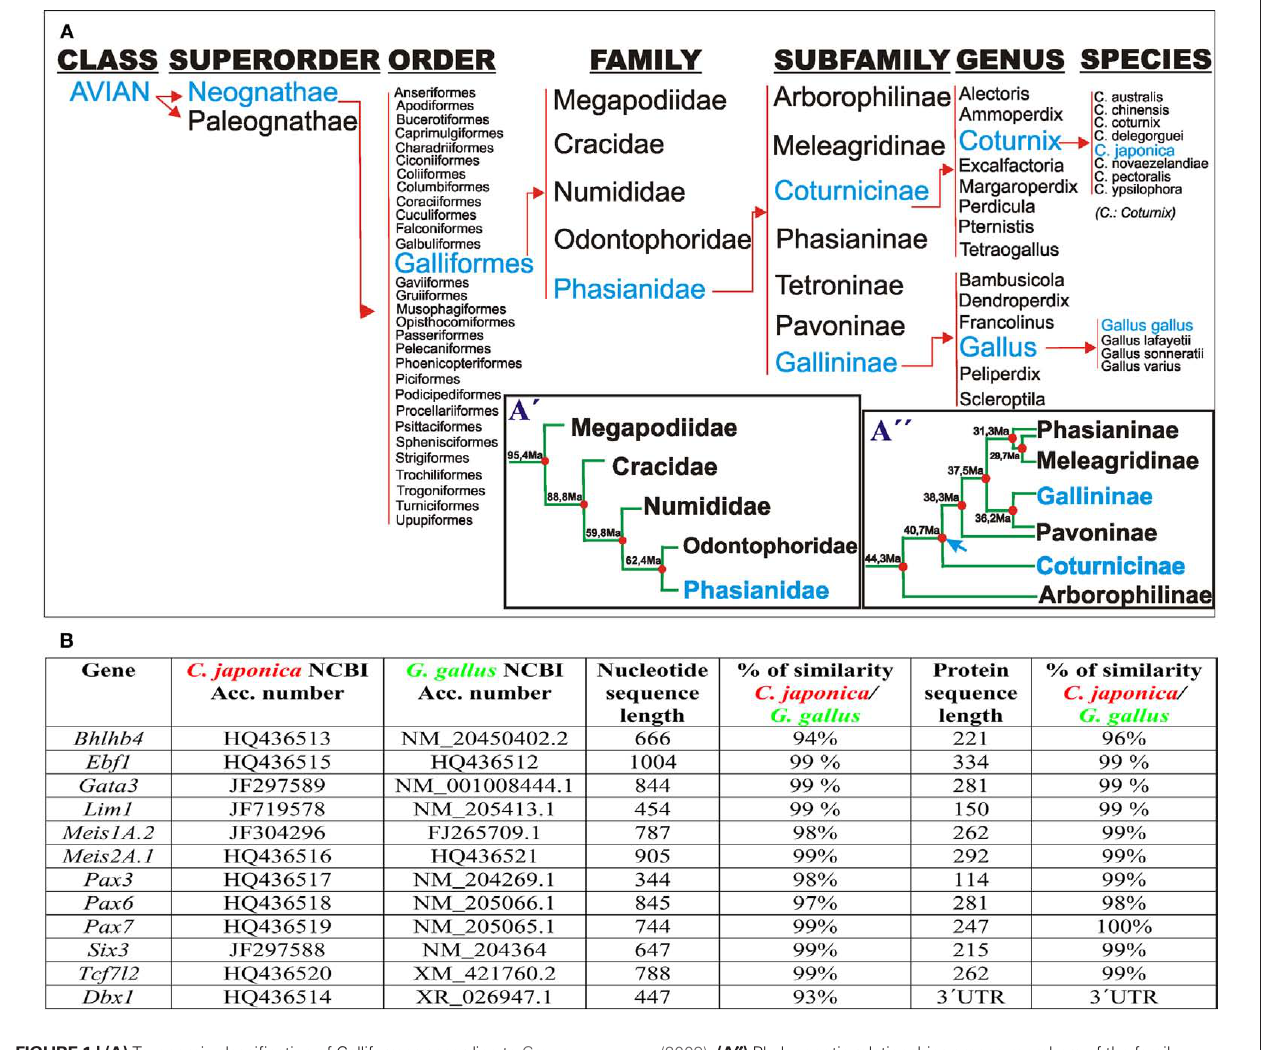
FIGure 1 | (A) Taxonomic classification of Galliformes according to Crowe et al. (2006). (A ′ ) Postulated phylogenetic relationships between families of the order galliformes . The timetree represents the mean times of independent evolution, estimated from several studies, according to Pereira and Baker